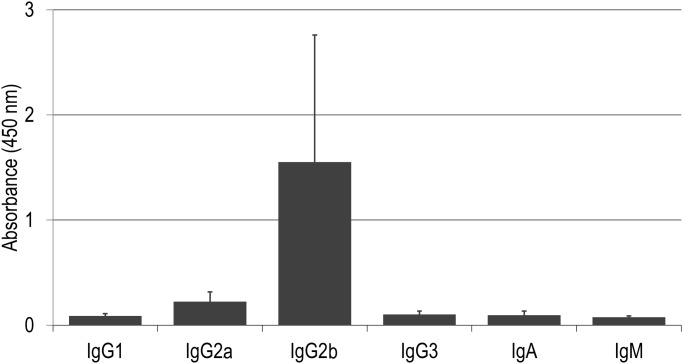
Typing of classes and subclasses of MPER-specific antibodies.Sera from GAD19-immunized mice were analyzed by ELISA. Each value plus SD (standard deviation) was shown.